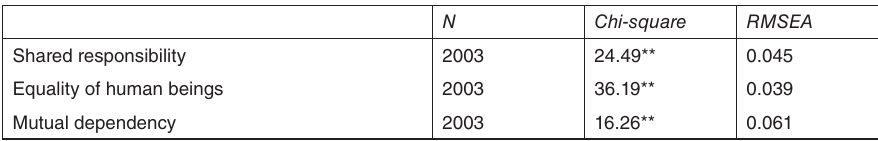
Table 3: Confirmative factor analyses of the three scales N